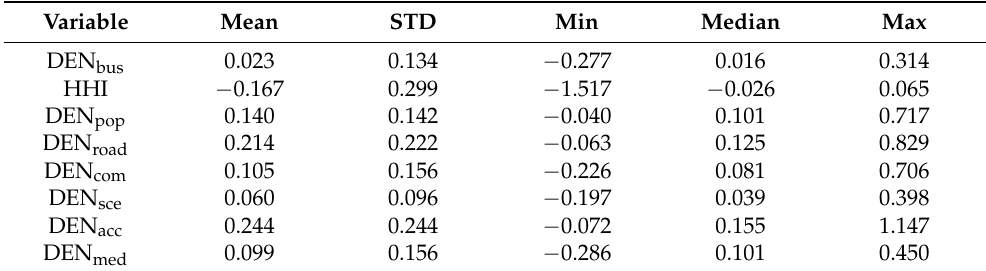
Table 6. Summary statistics for GWR parameter estimates.